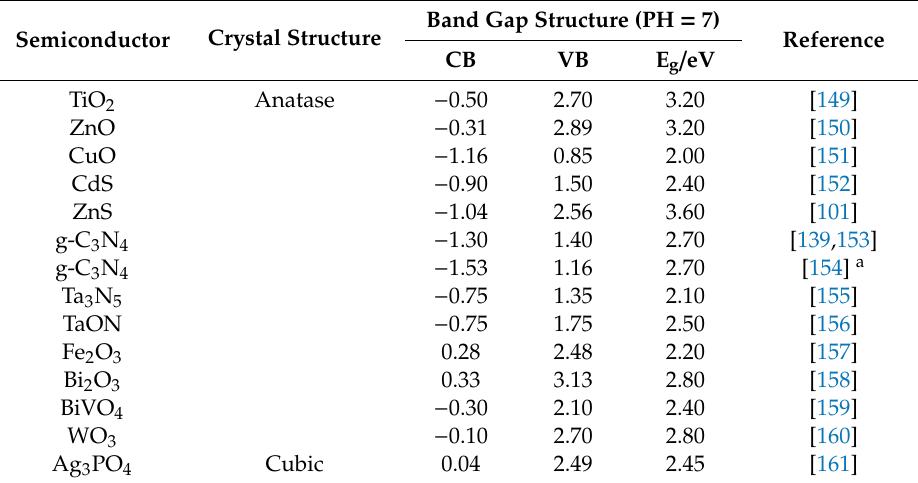
Table 2. Band gaps of common photocatalysts.